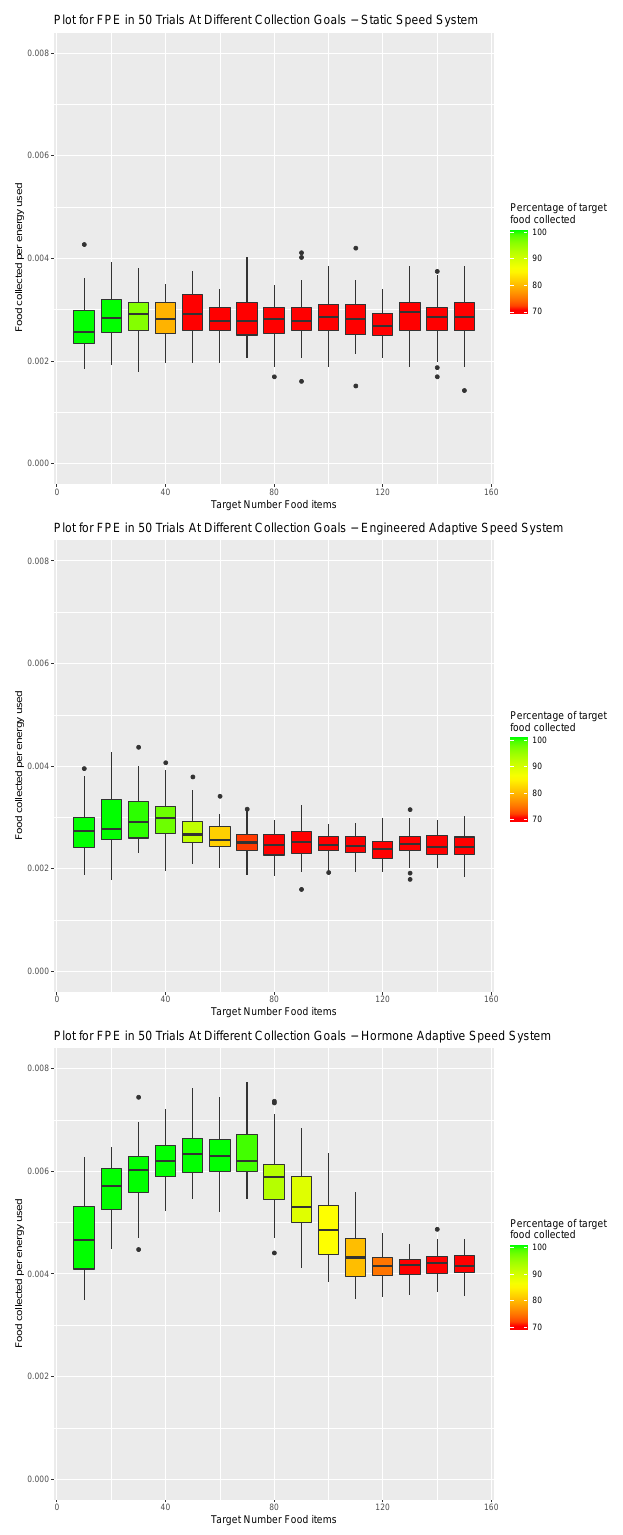
Figure 7. Three systems tested in in environment 2. Target number for items collected ranged from 10 to 150 items of food. Percentage of the items requested versus those collected by the end of the simulation is indicated by colour (Green 100% and Red <